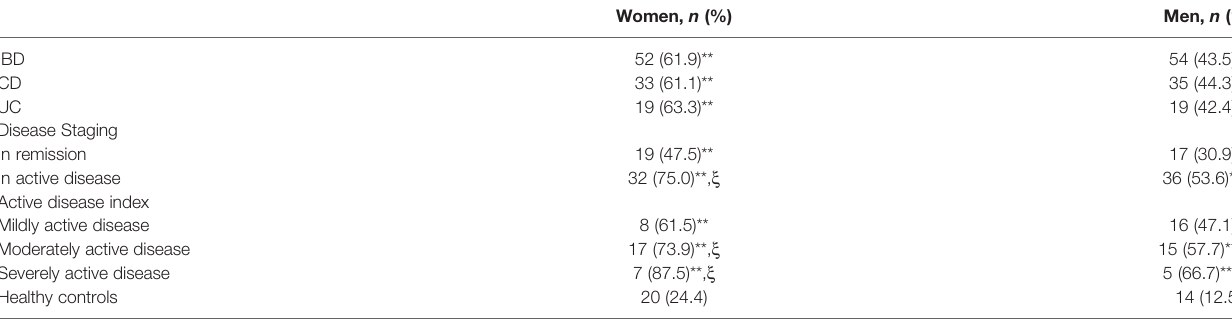
TABLE 3 | Prevalence and subgroup analysis of sexual dysfunction in IBD patients.